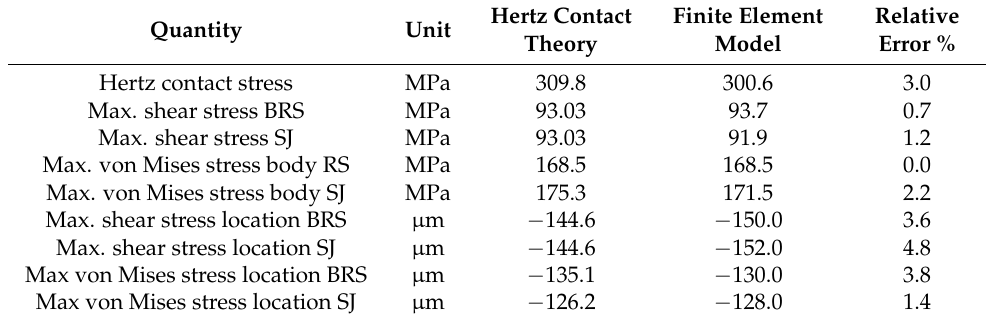
Table 2. Summary of the calculation results of the maximum stresses and the depths of their occurrence for the steel shaft journal (SJ) and the aluminum–bronze roller support (BRS), after a reaction force of R = 1253 N.